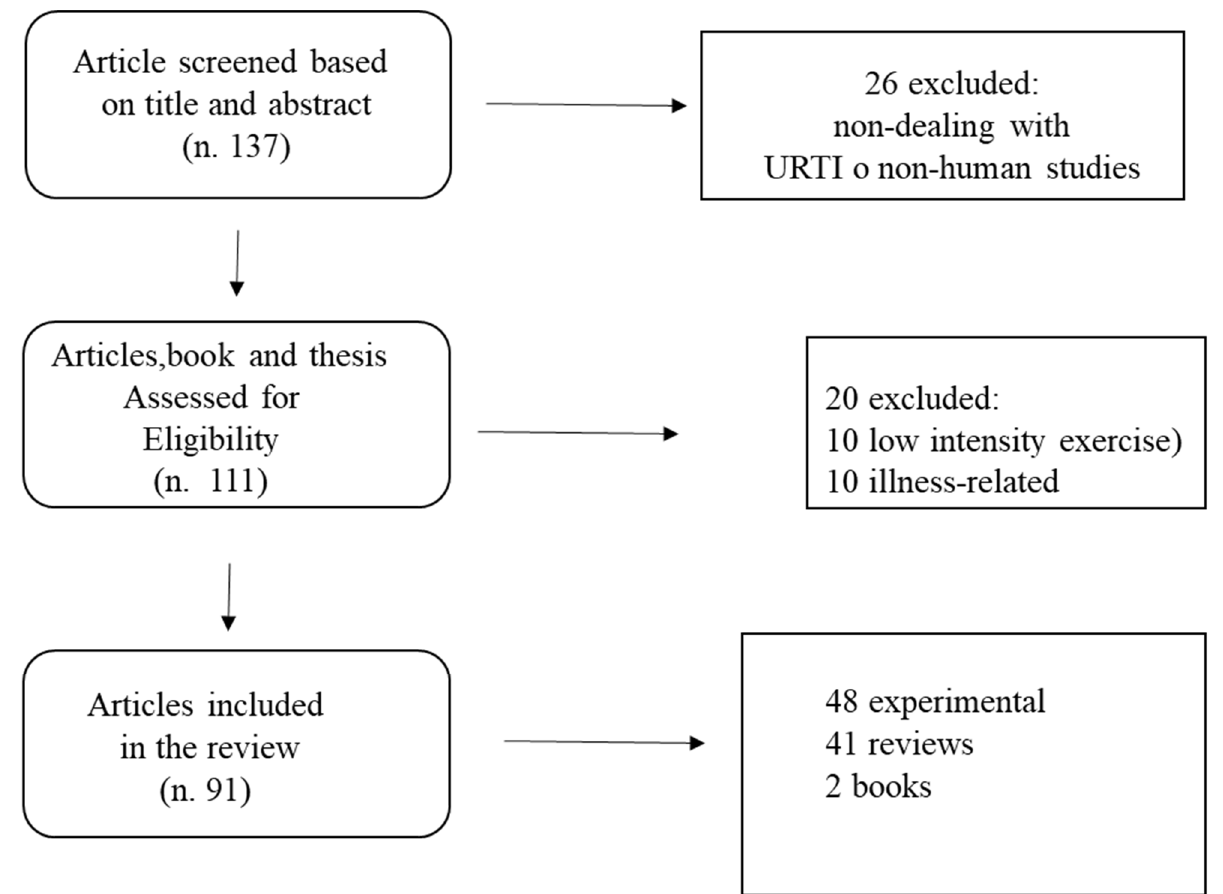
Figure 1. Flow chart of the search strategy (URTI: Upper Respiratory Tract Infection).